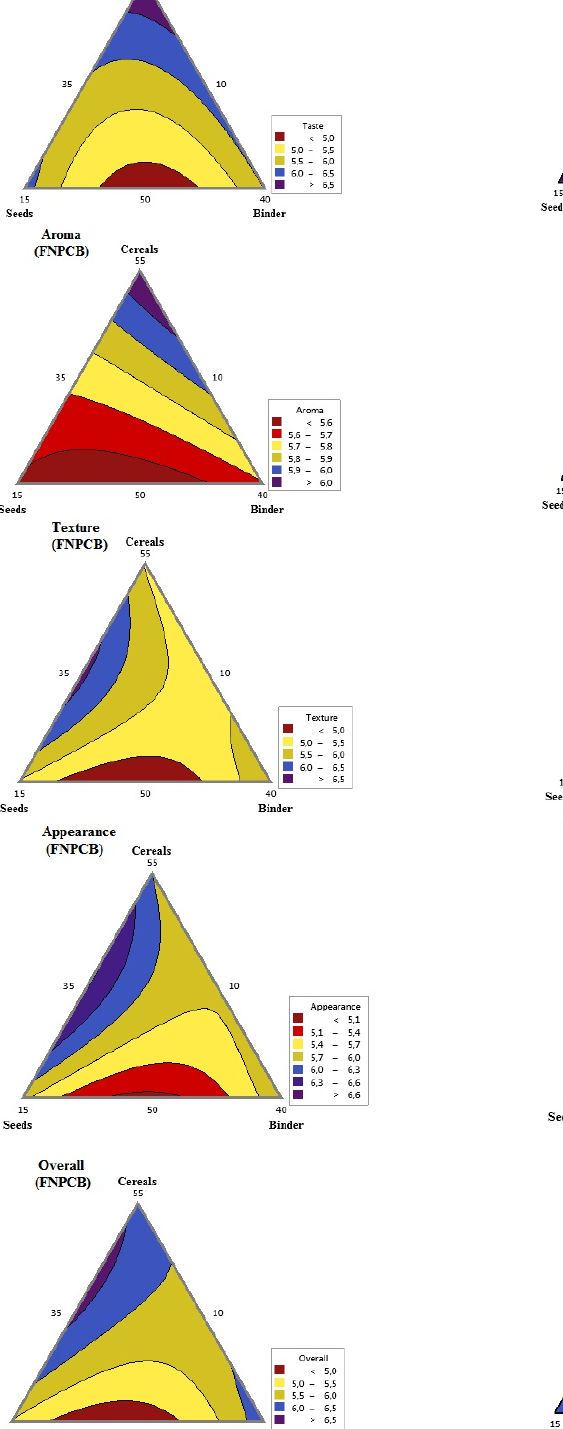
For energy non-puffed cereal bars (ENPCB), the contour plots showed an increasing